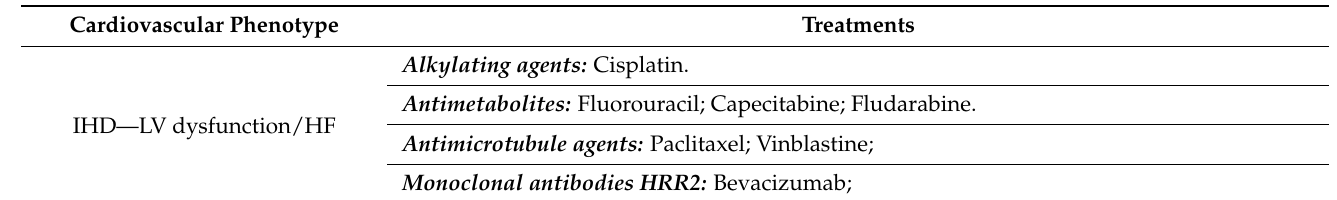
Table 1. Cardiovascular phenotypes associated with anticancer treatments (reported in details elsewhere